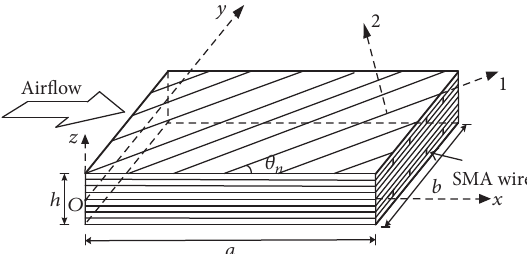
Figure 1: Schematic illustration of a smart laminated